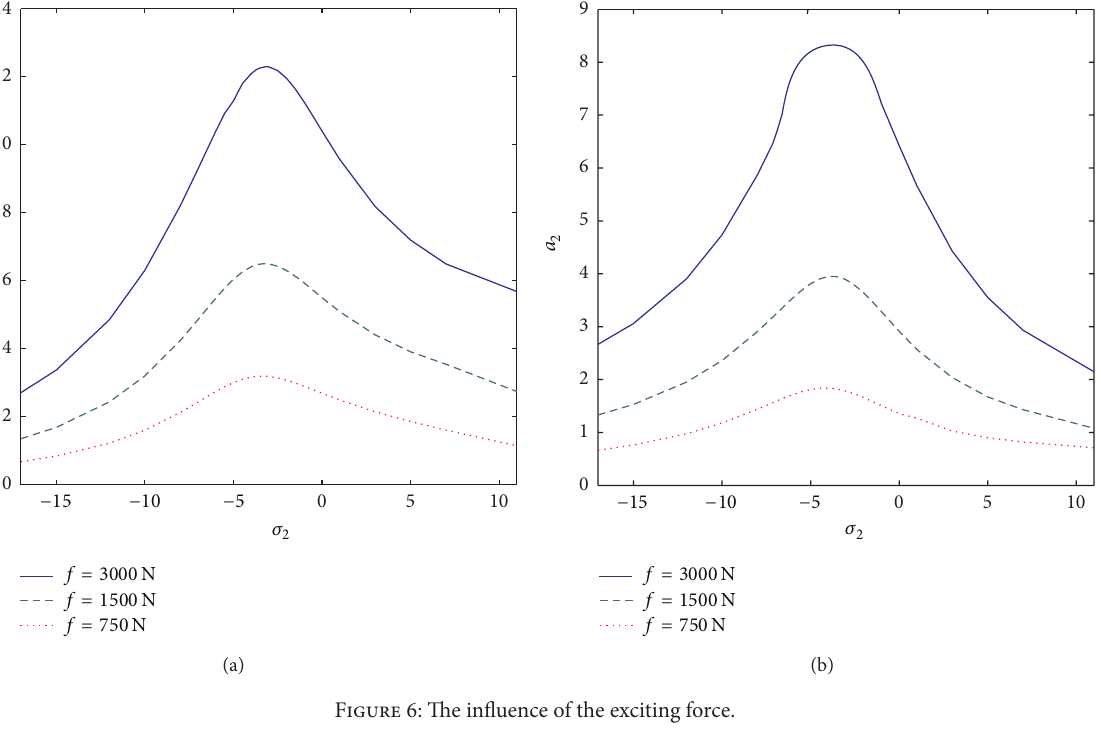
Figure 6: The influence of the exciting force.